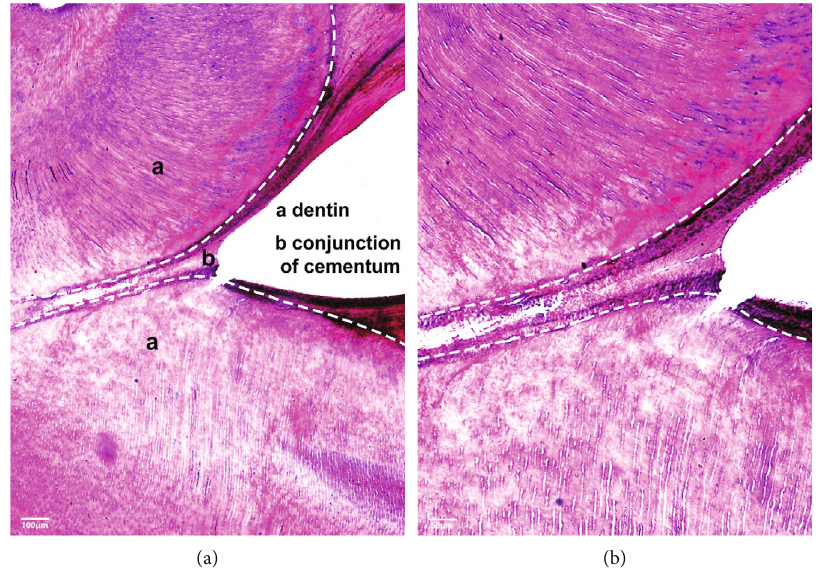
Figure 3: Photomicrographs of histological sections stained with the hematoxylin – eosine stain exhibiting the point of cementum fusion, revealing a real concrescence. Images obtained using (a) a 10x microscope and (b) a 20x microscope.